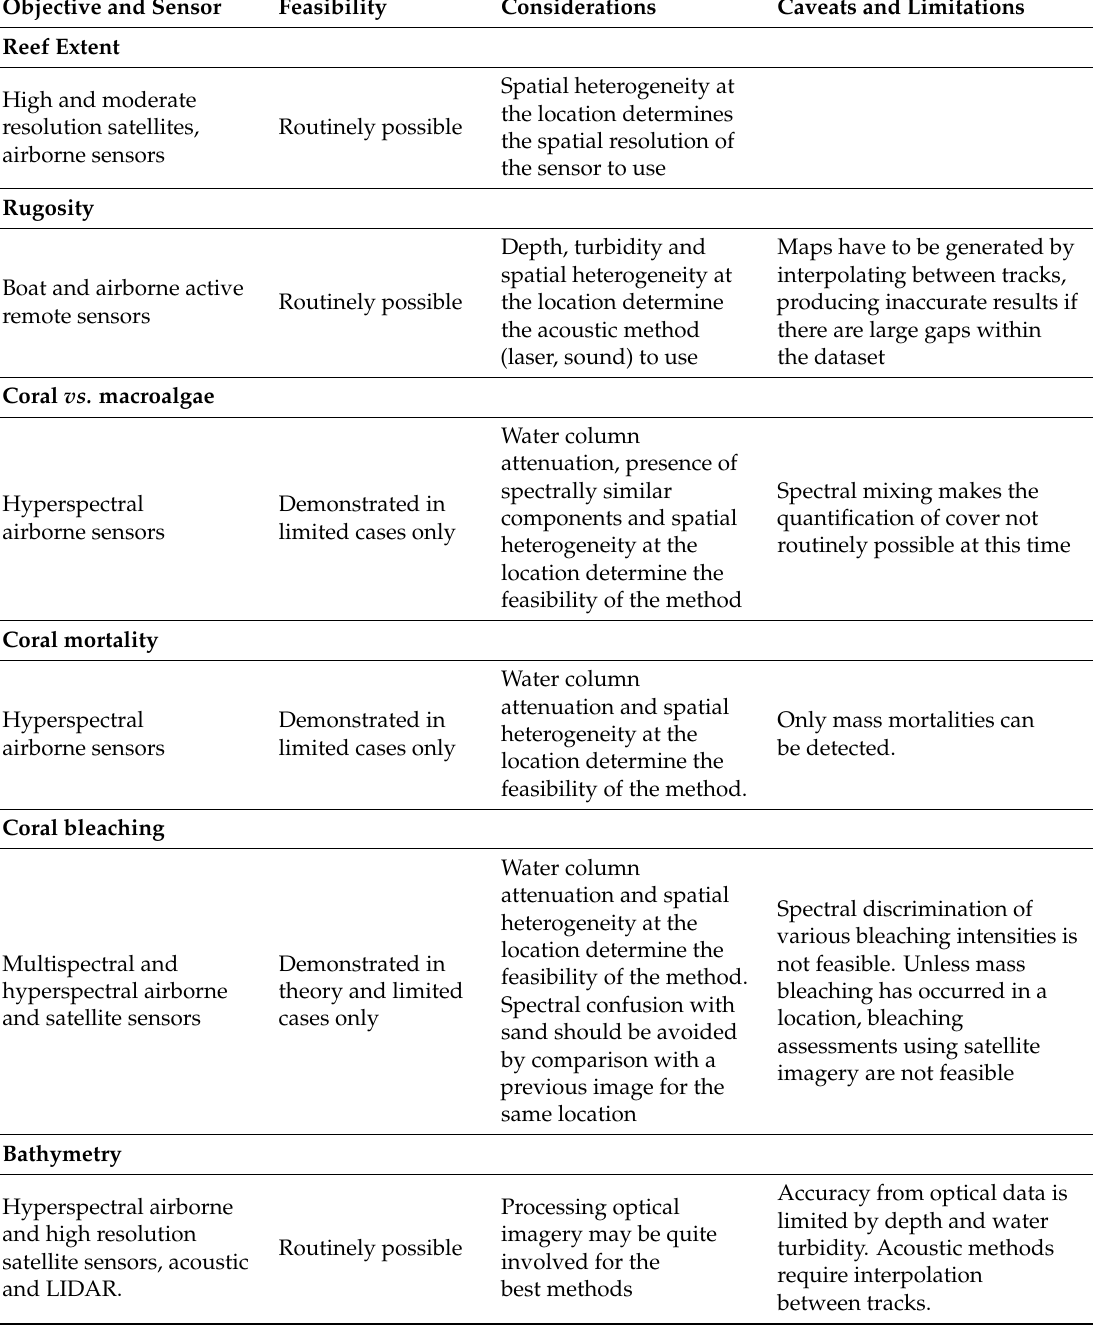
Table 1. Available remote sensing technologies for coral reef